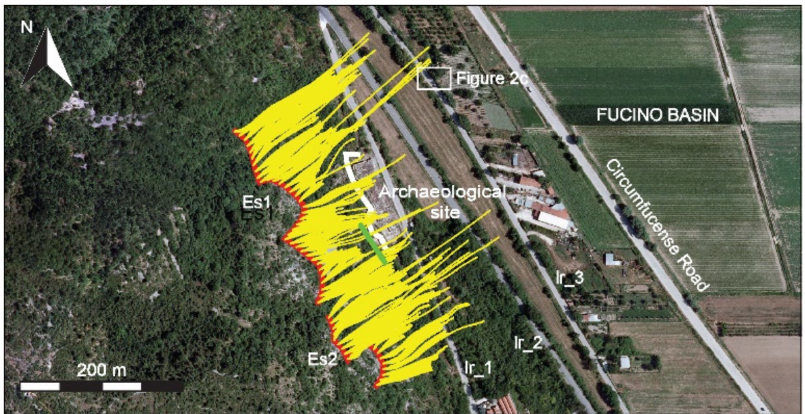
Figure 8. Rock block trajectories map and location of present barrier (thick green line). Position of two blocks shown in Figure 2c is indicated, featuring a 230 m maximum run-out